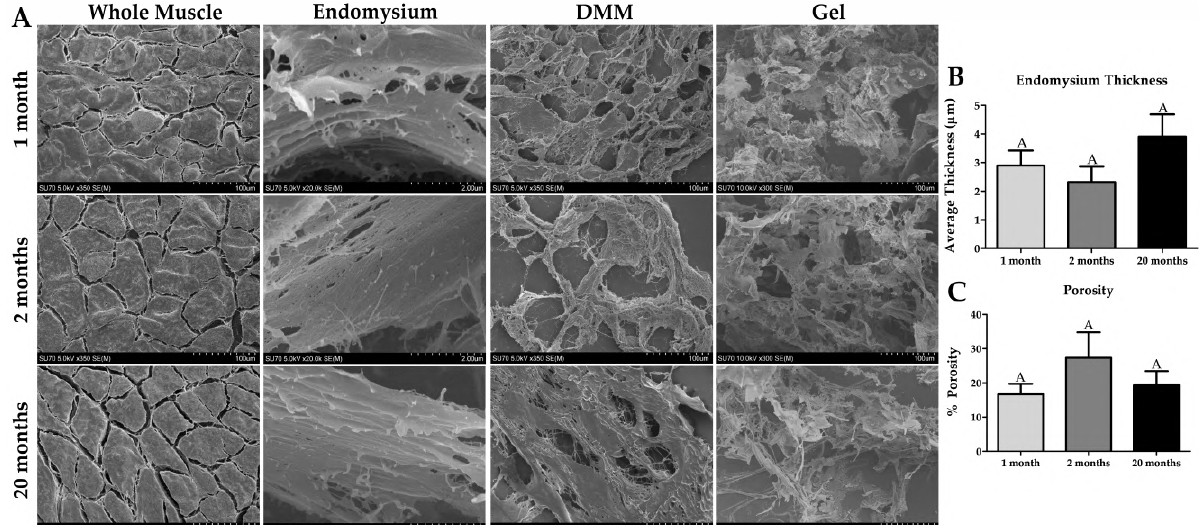
Figure 4. Scanning Electron Imaging shows distinctions in ECM structure with age in native muscle, decellularized muscle matrix (DMM), and processed DMM gels. ( A ) The muscle fibers are surrounded by endomysium in the whole muscle images, and the space between the muscle fibers appear to increase with age, however not significantly. DMM (n = 4 for 20 ‐ month DMM) and processed DMM gels, there is an obvious sclerotic structure indicating the presence of polymerized ECM such as collagen. ( B ) Endomysium thickness trends upwards with age but is not significantly different. ( C ) The porosity of DMM is not affected by age. Groups that do not share a letter (e.g. A) are statistically different according to a one ‐ way ANOVA followed by a two ‐ tailed Tukey’s correction ( p < 0.05, n = 6 except the 20 ‐ month ‐ old muscle has n = 4).